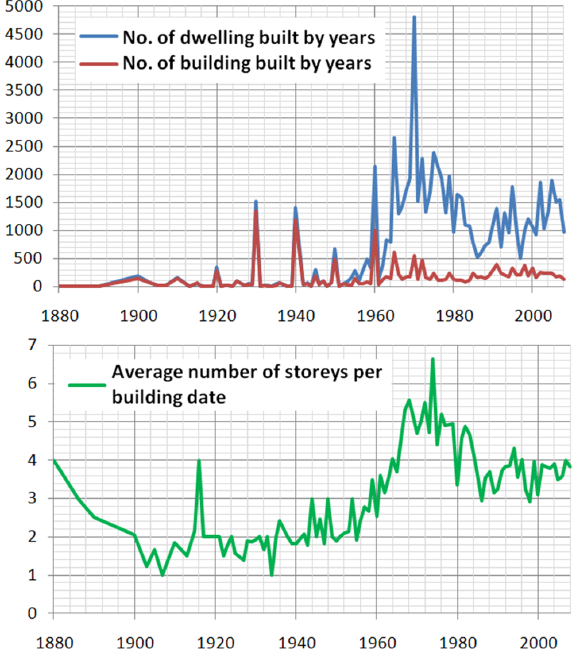
Fig. 5. (top) Distribution of buildings and dwellings by year of construction. (bottom) Average number of floors of buildings per